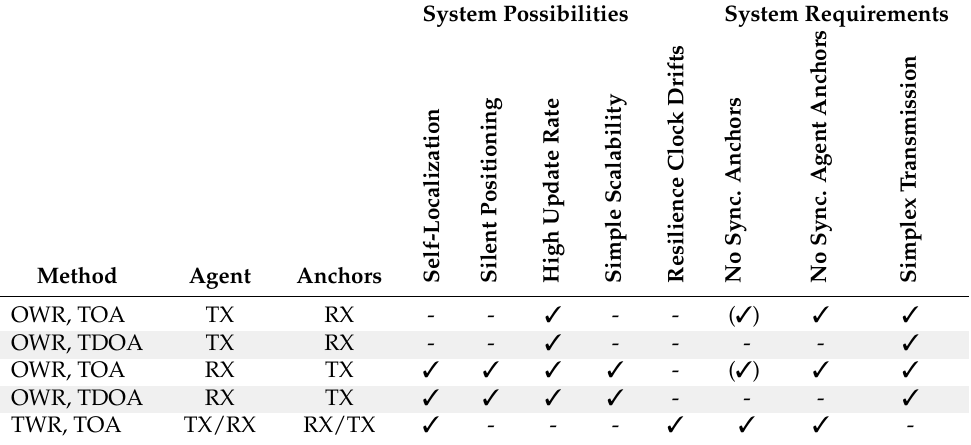
Table 2. Summary of typical ranging methods between agent (for example the vehicle) and anchors (reference points). The category simplex transmission refers to devices that only transmit or receive. For example, the agent sends broadcast signals to the anchors. This reduces the amount of hardware compared to an application where agent and anchors have to transmit and to receive. Abbrevia- tions: one way ranging (OWR), two way ranging (TWR), time of arrival (TOA), time difference of arrival (TDOA), transmitter (TX), receiver (RX). System Possibilities System Requirements